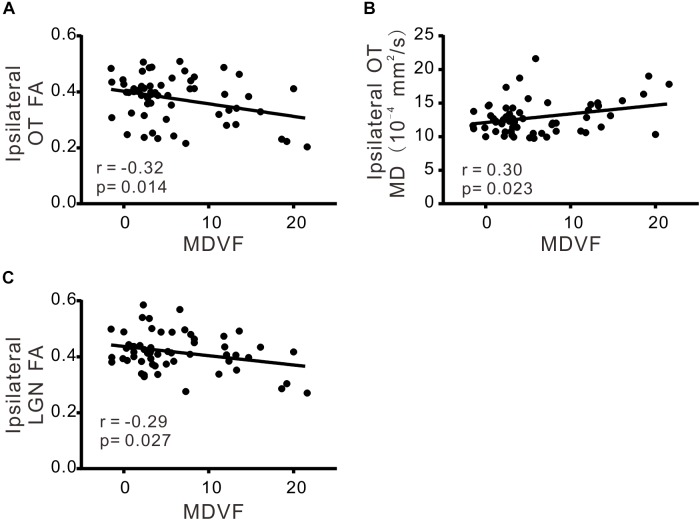
The correlations of DTI parameters and MDVF. FA (A) and MD (B) in ipsilateral OT, FA in ipsilateral LGN (C) were significantly correlated with MDVF.